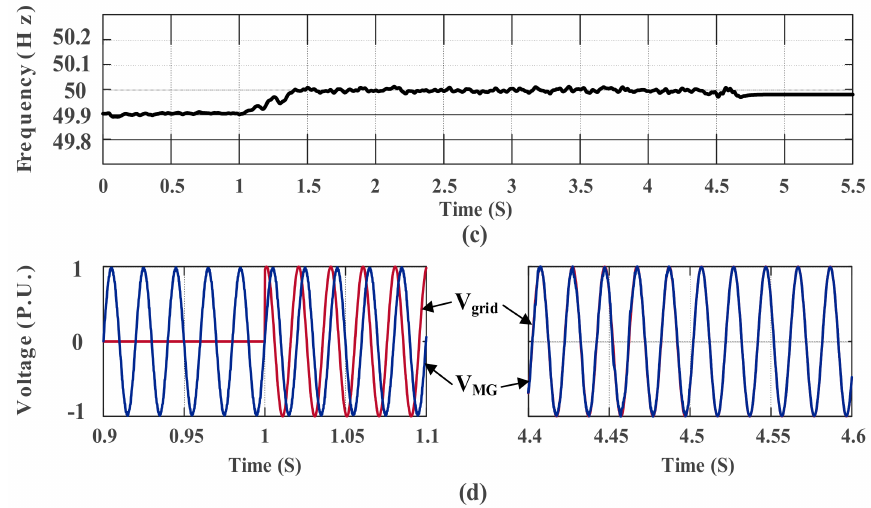
Figure 14. Simulation results of synchronization and reconnection to the main grid: ( a ) Active and reactive powers absorbed from main grid; ( b ) MG voltage; ( c ) MG frequency; ( d ) The difference in phase angle before the synchronization (0.9 s to 1.1 s) and after the synchronization (4.4 s to 4.6